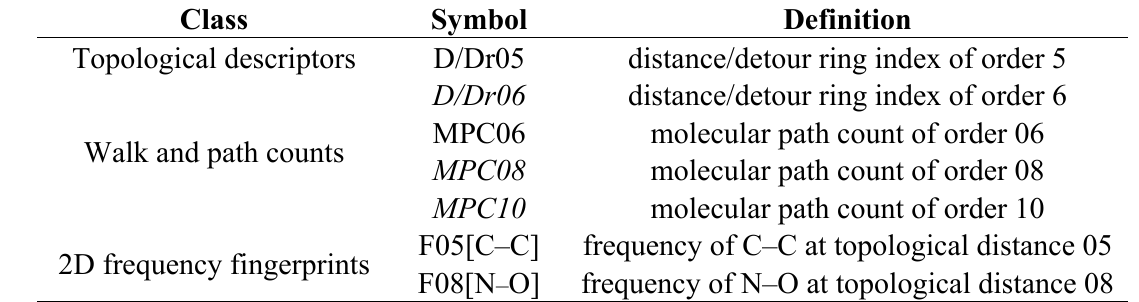
Table 1. Molecular descriptors from RF feature selection method.